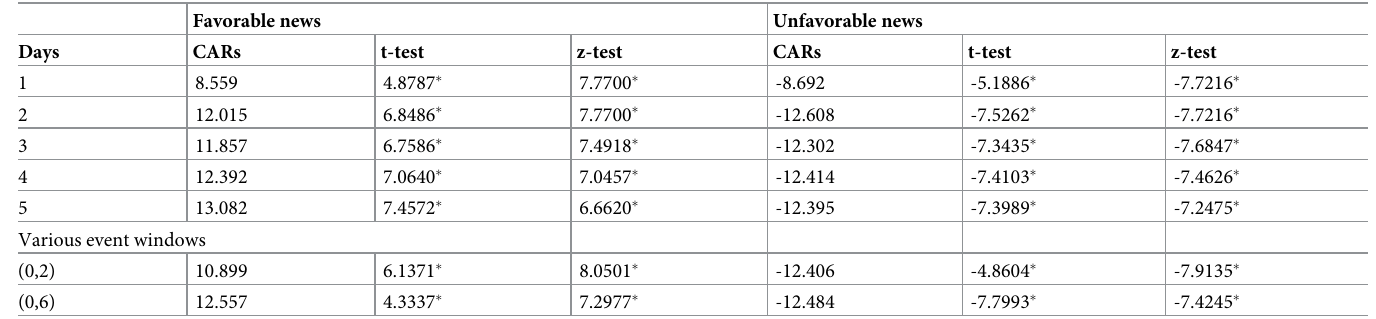
Table 4. Post-event CARs for the whole period (1.01.2011–12.08.2021)–favorable and unfavorable